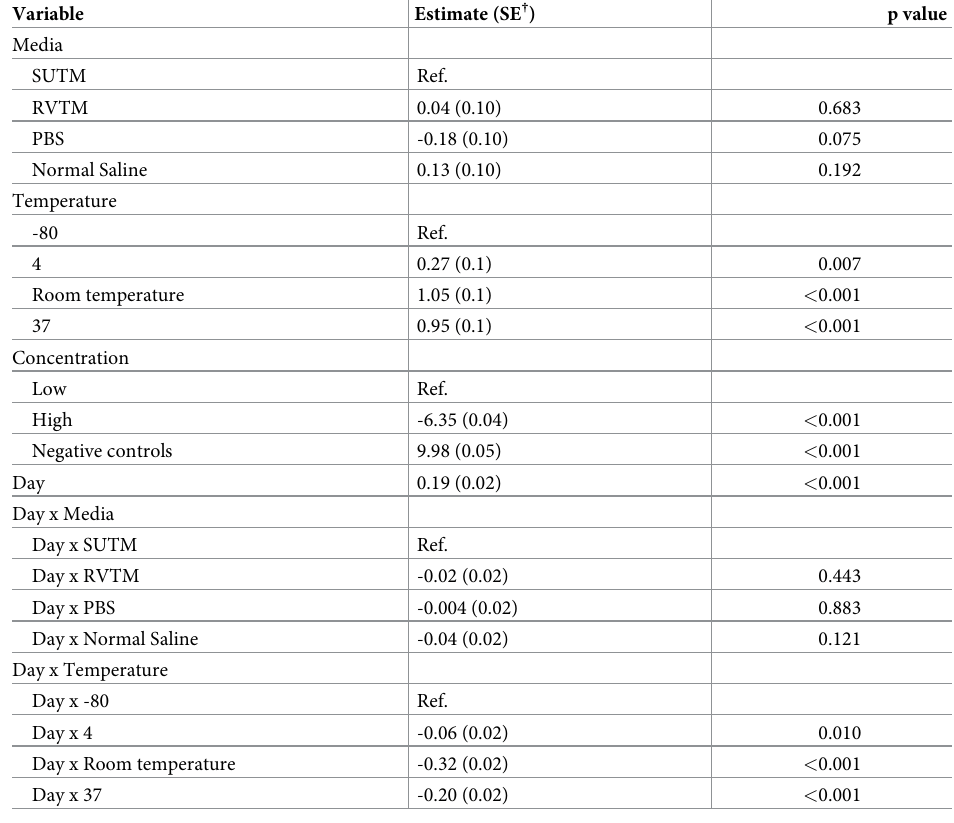
Table 2. Multiple linear regression analysis to compare the differences between the